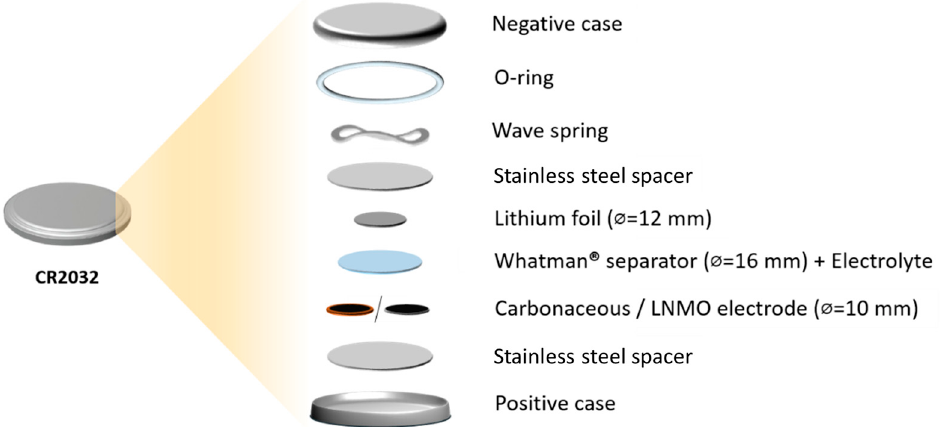
Figure 2. Coin cell configuration for galvanostatic cycling.